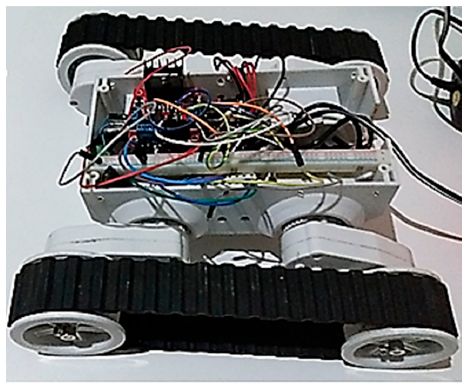
Figure 4. Overview of the robotic unit used.